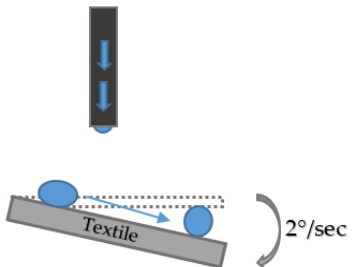
Figure 4. Water sliding angle “WSA” measurements.